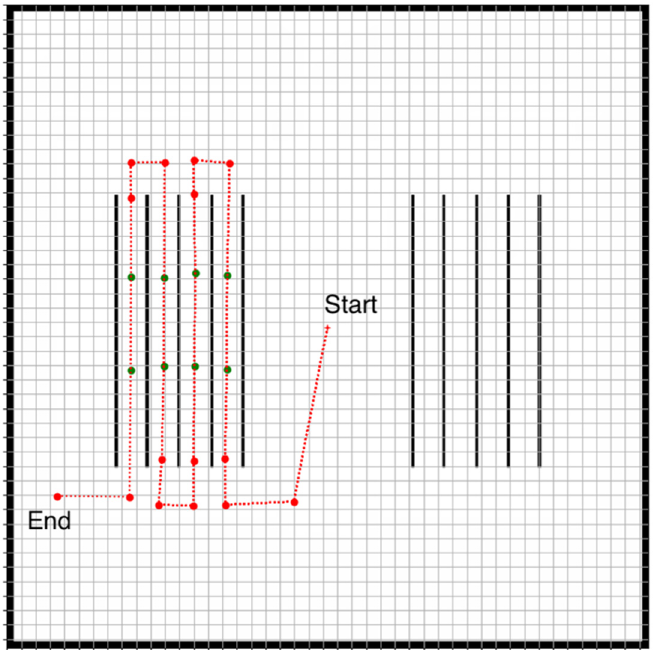
Figure 4. Path selection using the base station’s user interface. The red dots are the selected waypoints, and the red line indicates the desired robot path. The green dots are work waypoints where the robots must stop and harvest. The red cross indicates the initial position of a robot. The black lines are the vineyard rows.